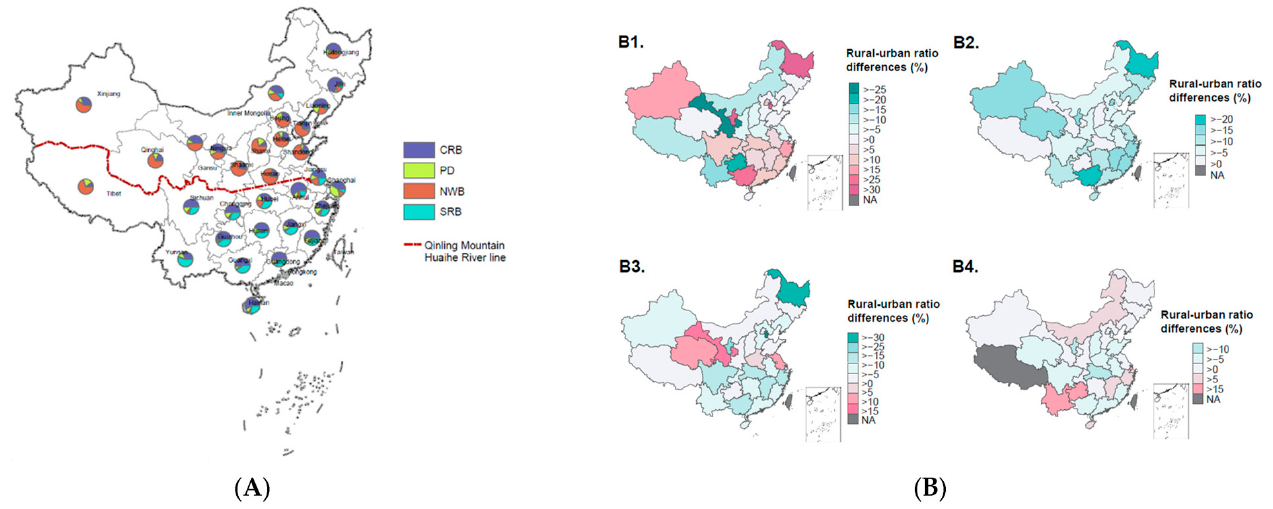
Figure 1. Geographic variations and rural–urban variations in dietary patterns across 31 provinces of China. ( A ). Age–sex standardized proportions of dietary patterns across 31 provinces of China; ( B ). The differences of age–sex standardized proportions of four dietary patterns between rural and urban areas; ( B1 – B4 ) represent common rice-based dietary pattern (CRB), prudent diversified dietary pattern (PD), northern wheat-based dietary pattern (NWB), and southern rice-based dietary pattern (SRB), respectively. CRB: common rice-based dietary pattern; PD: prudent diversified dietary pattern; NWB: northern wheat-based dietary pattern; SRB: southern rice-based dietary pattern; NA: not